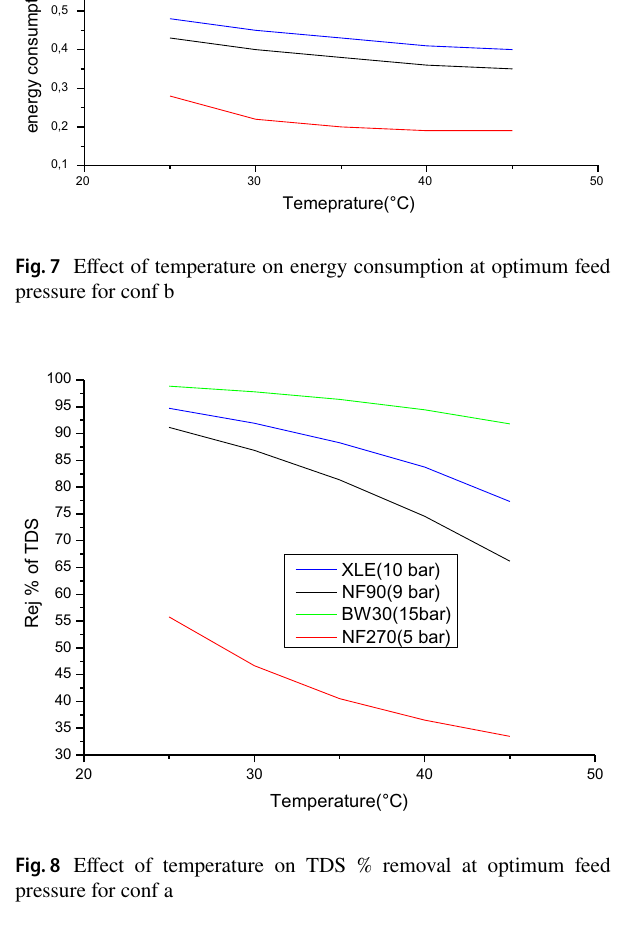
Fig.6 Effect of temperature on energy consumption at optimum feed pressure for conf a